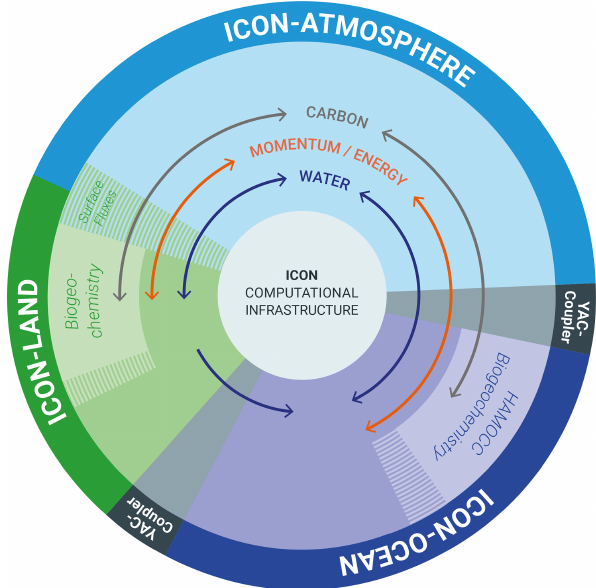
Figure 1. Overview of the components of the ICON-Sapphire con- figuration with their